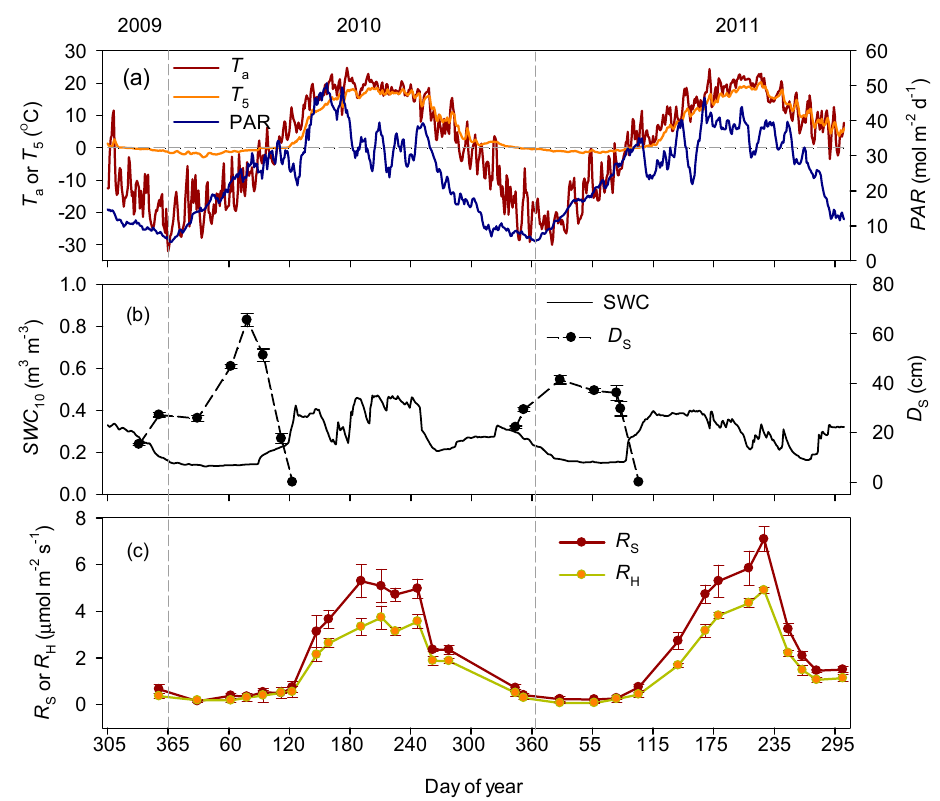
Figure 1. Seasonal dynamics of ( a ) daily air temperature at 16 m height ( T a ), daily soil temperature at 5 cm depth ( T 5 ), and daily photosynthetically active radiation ( PAR ); ( b ) daily soil volumetric water content at 0–10 cm depth ( SWC 10 ), snow depth ( D S ), and ( c ) soil CO 2 efflux ( R S ) and CO 2 efflux from trenched plots ( R H ) from November 2009 to October 2011. The error bars are standard deviations of the three plots. The vertical dash lines in the figure indicate the end of the year, and the horizontal dash line is zero temperature.